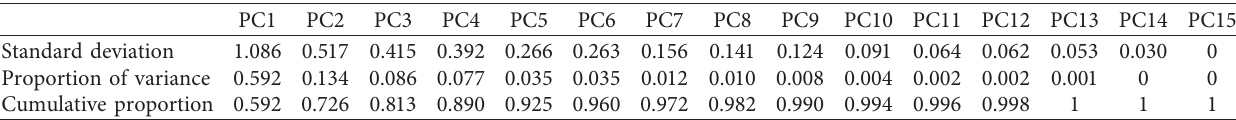
Table 2: Evaluation of the importance of the first 15 principal components (PC1–PC15).